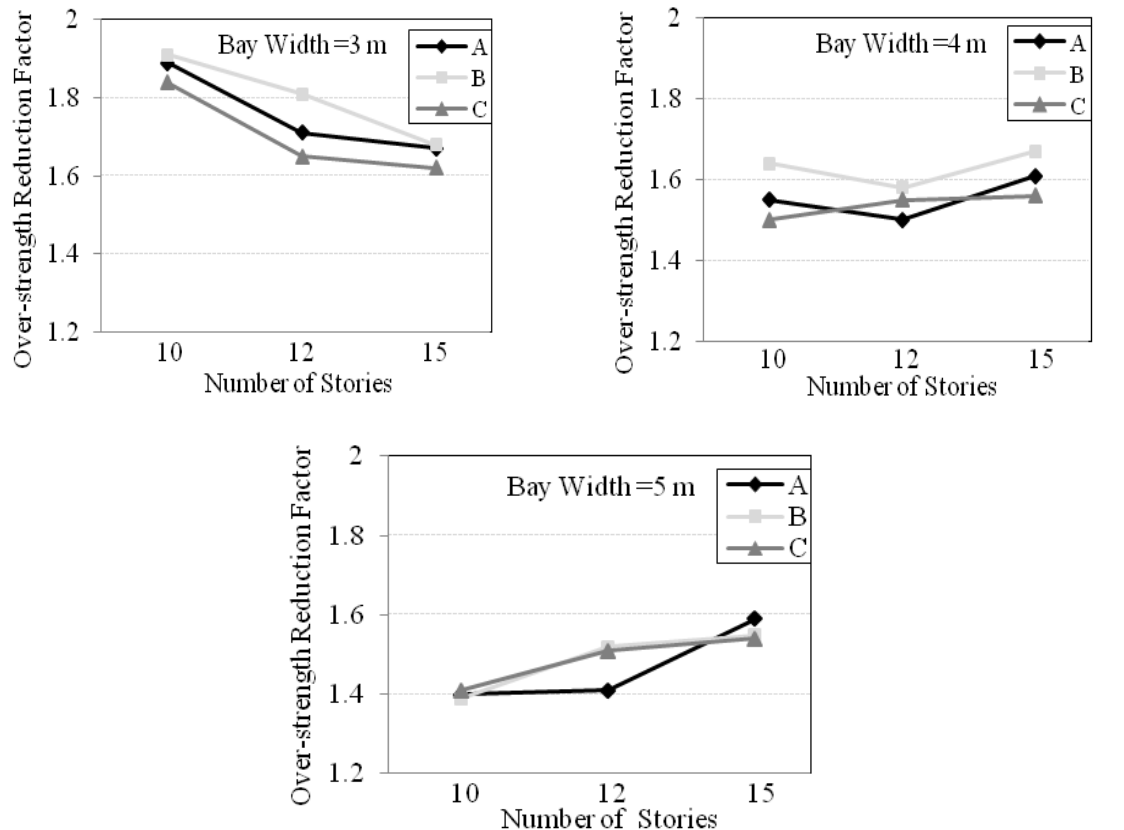
Fig. 7. Variation of over strength reduction factor for different number of